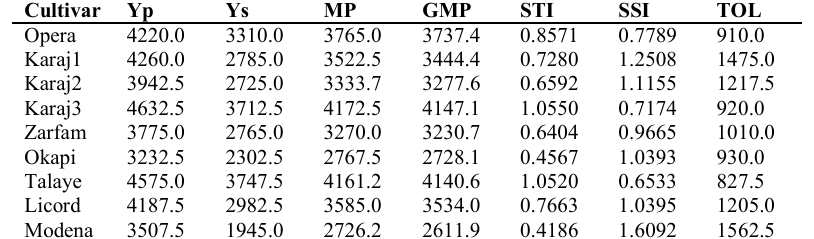
Table 4. The amounts of yields in normal and stress conditions and drought resistance indices in studied rapeseed culti- vars Cultivar